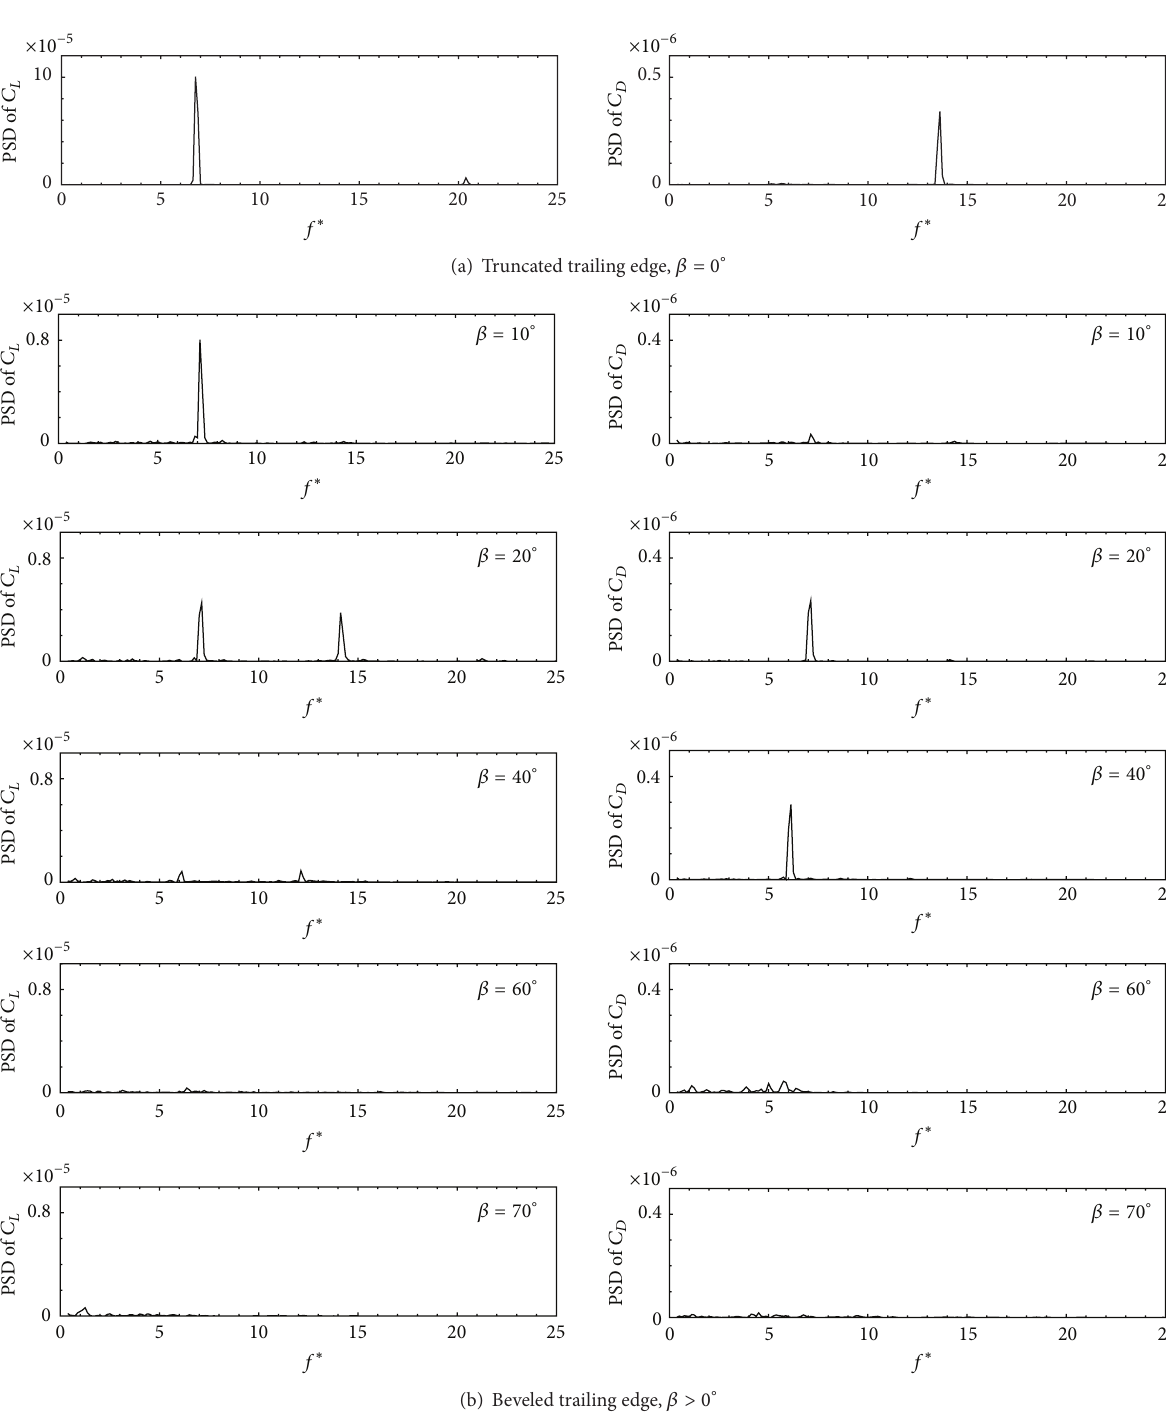
Figure 6: Power spectral density (PSD) of the lift and drag coefficients. 𝑓 ∗ denotes the frequency normalized by the chord length and the undisturbed flow